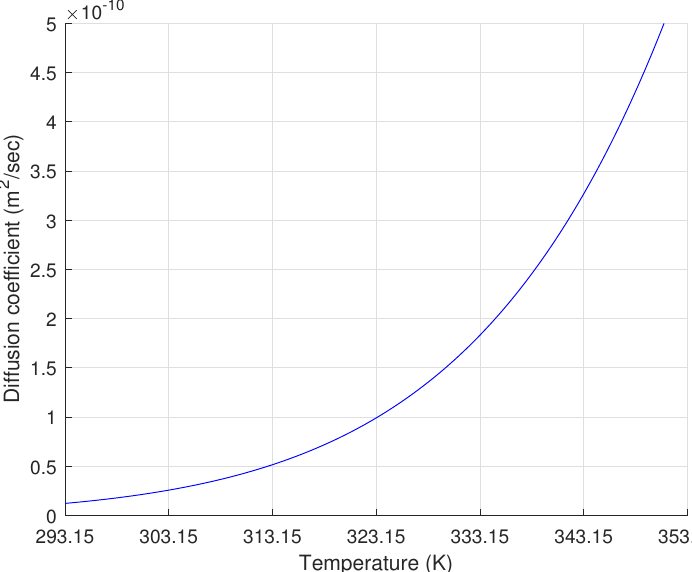
Figure 3. Diffusion coefficient of methane in the XLPE changed due to the temperature change from room temperature, 293.15 K (20 ◦ C), to the maximum degassing chamber temperature, 353.15 K (80 ◦